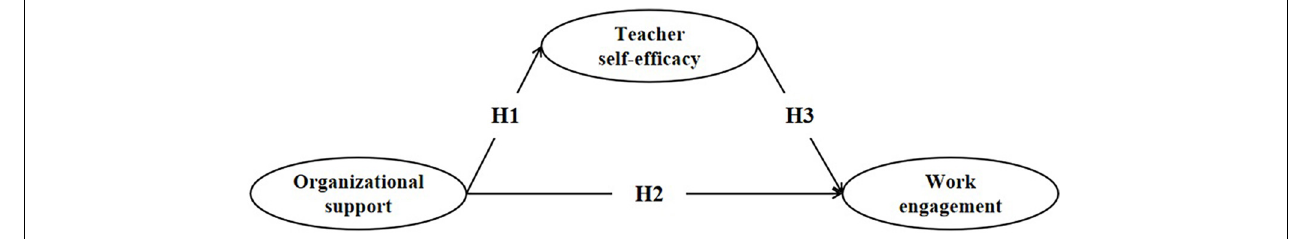
FIGURE 1 | Research model.